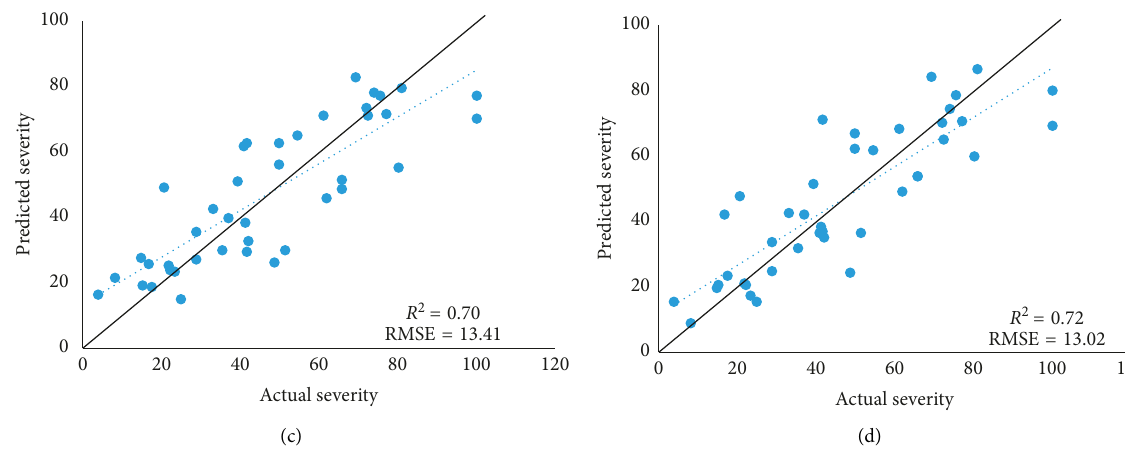
Figure 8: Leave-one-out cross validation for (a) SD y , (b) NBNDVI, (c) WSI, and (d) multiple stepwise